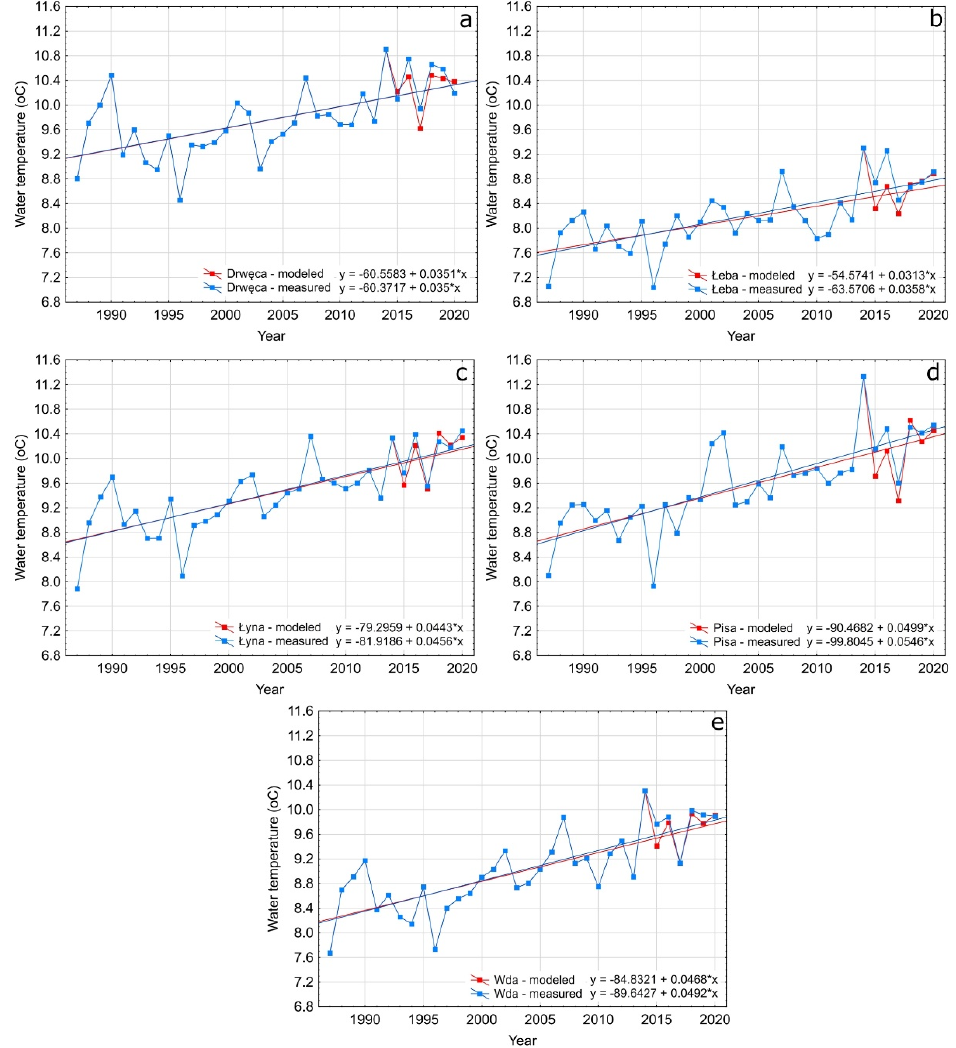
Figure 6. Trendline slope value in the years 1987–2020 for the original measurement data (blue line) and reconstructed data (red line) for rivers: Drw˛eca ( a ), Łeba ( b ), Łyna ( c ), Pisa ( d ) and Wda ( e ). Eventually, based on knowledge pertaining to the selection of the statistical model and the selection of a data set for the supplementation of missing water temperatures, reconstruction was performed. The results for all the analysed rivers are presented in Table 4. Table 4. Trendline slope values (Sen slope) in °C per decade in river waters in Poland .